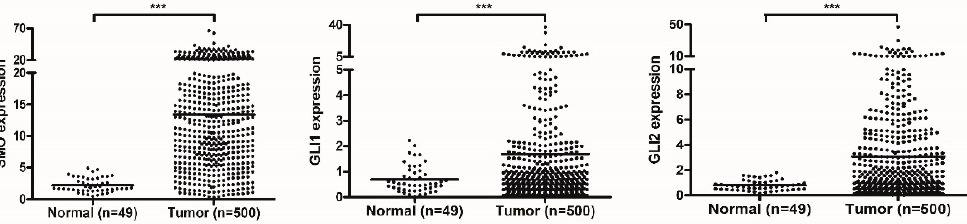
Figure 3. The Hh pathway components are overexpressed in the LSCC cohort of TCGA. Scatter plots of gene expression